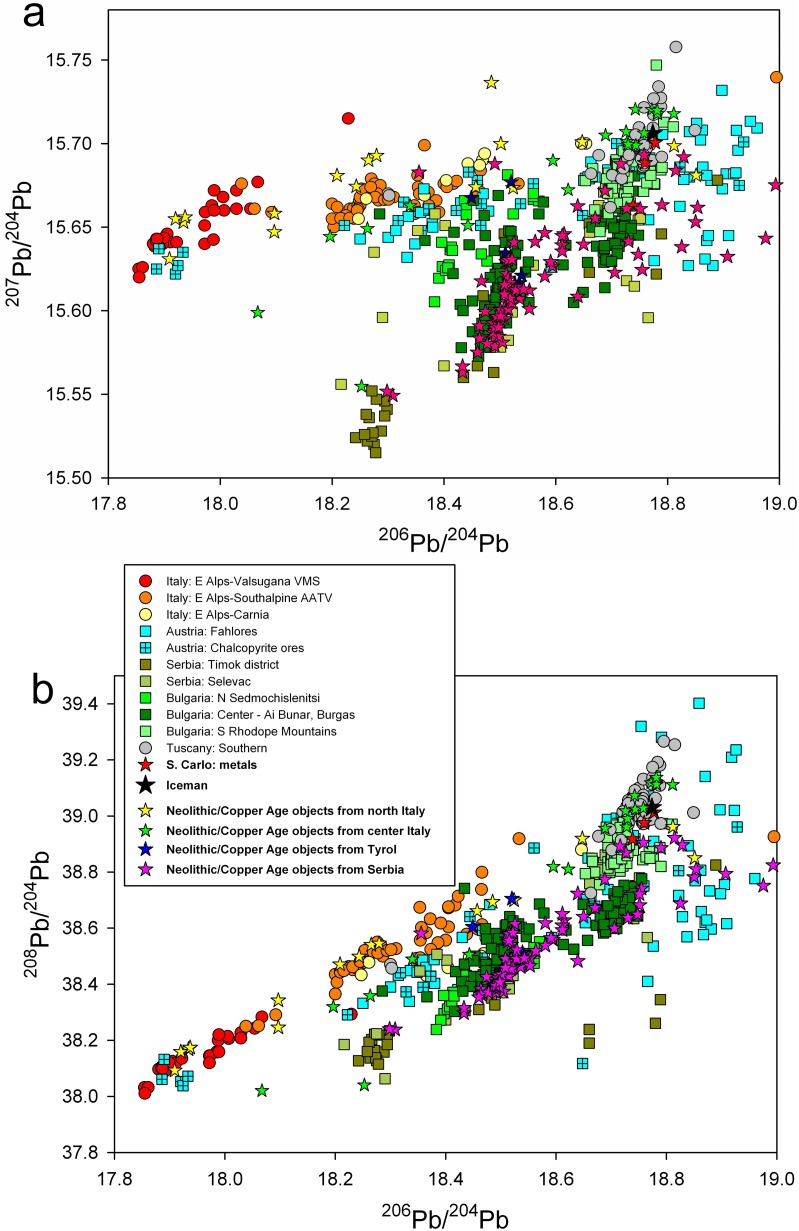
2D projections of the available lead isotope data for Neolithic and Copper Age objects from Italy [22, 31, 39, 54–55], Tyrol [41], and Serbia [42–56] (from the late 5th millennium to the early 3rd millennium BC).(a) 206Pb/204Pb vs 207Pb/204Pb plot; (b) 206Pb/204Pb vs 208Pb/204Pb plot.